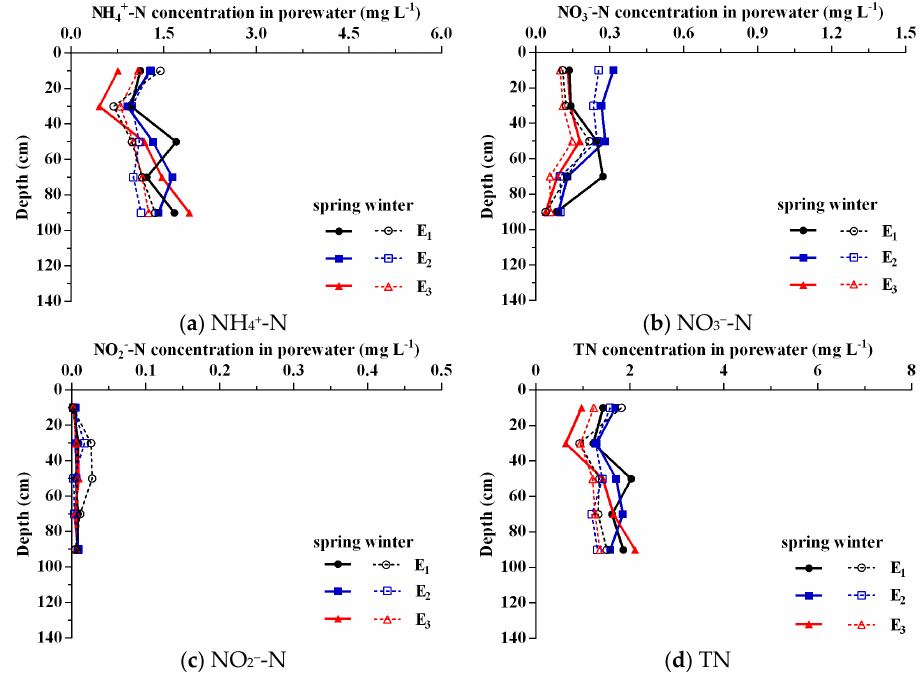
Figure 2. Vertical profiles of nitrogen in the porewater of the hyporheic zone at the east sites in Lake Taihu during spring and winter 2016.